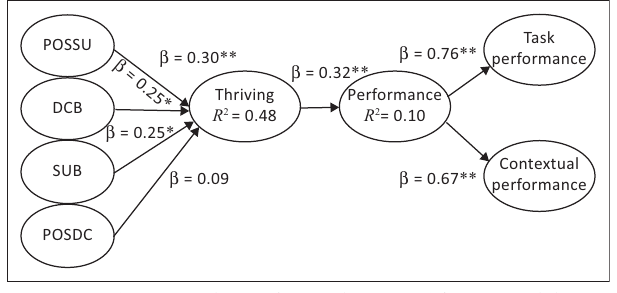
FIG URE 1: A structural model of thriving and performance.